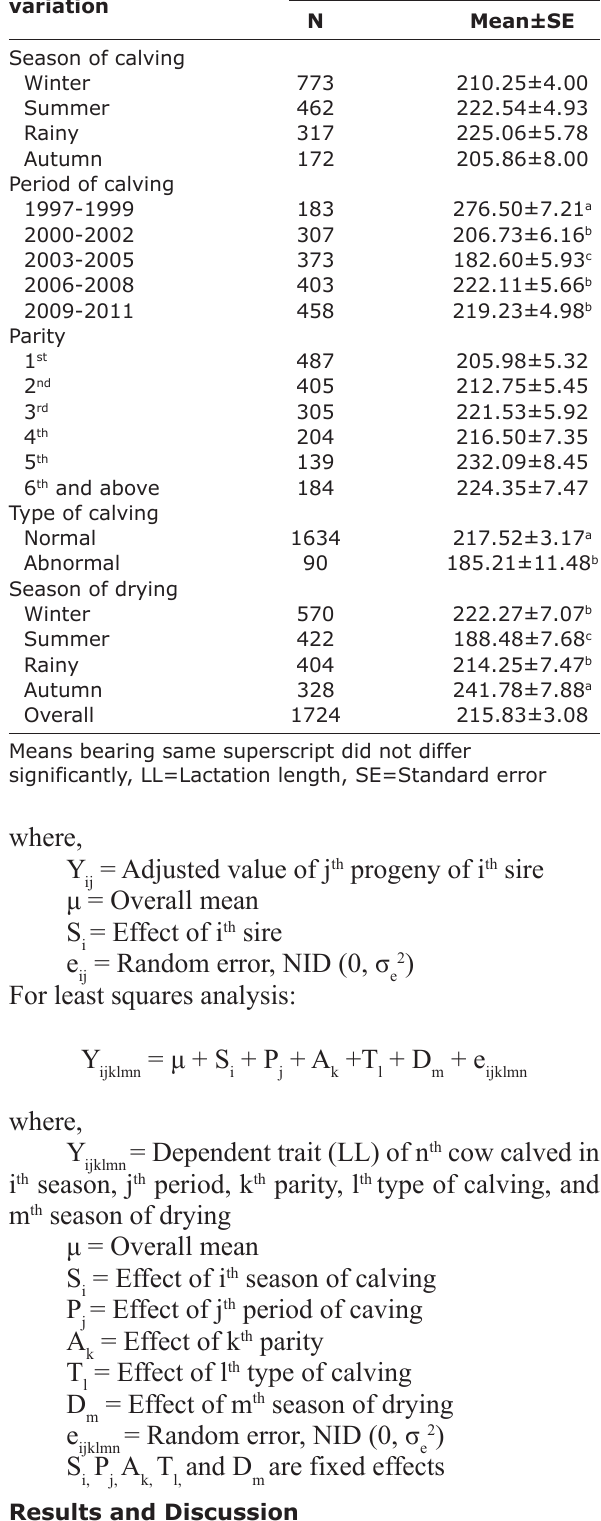
Table-1: Least squares means±SE of LL in Sahiwal cattle. Sources of